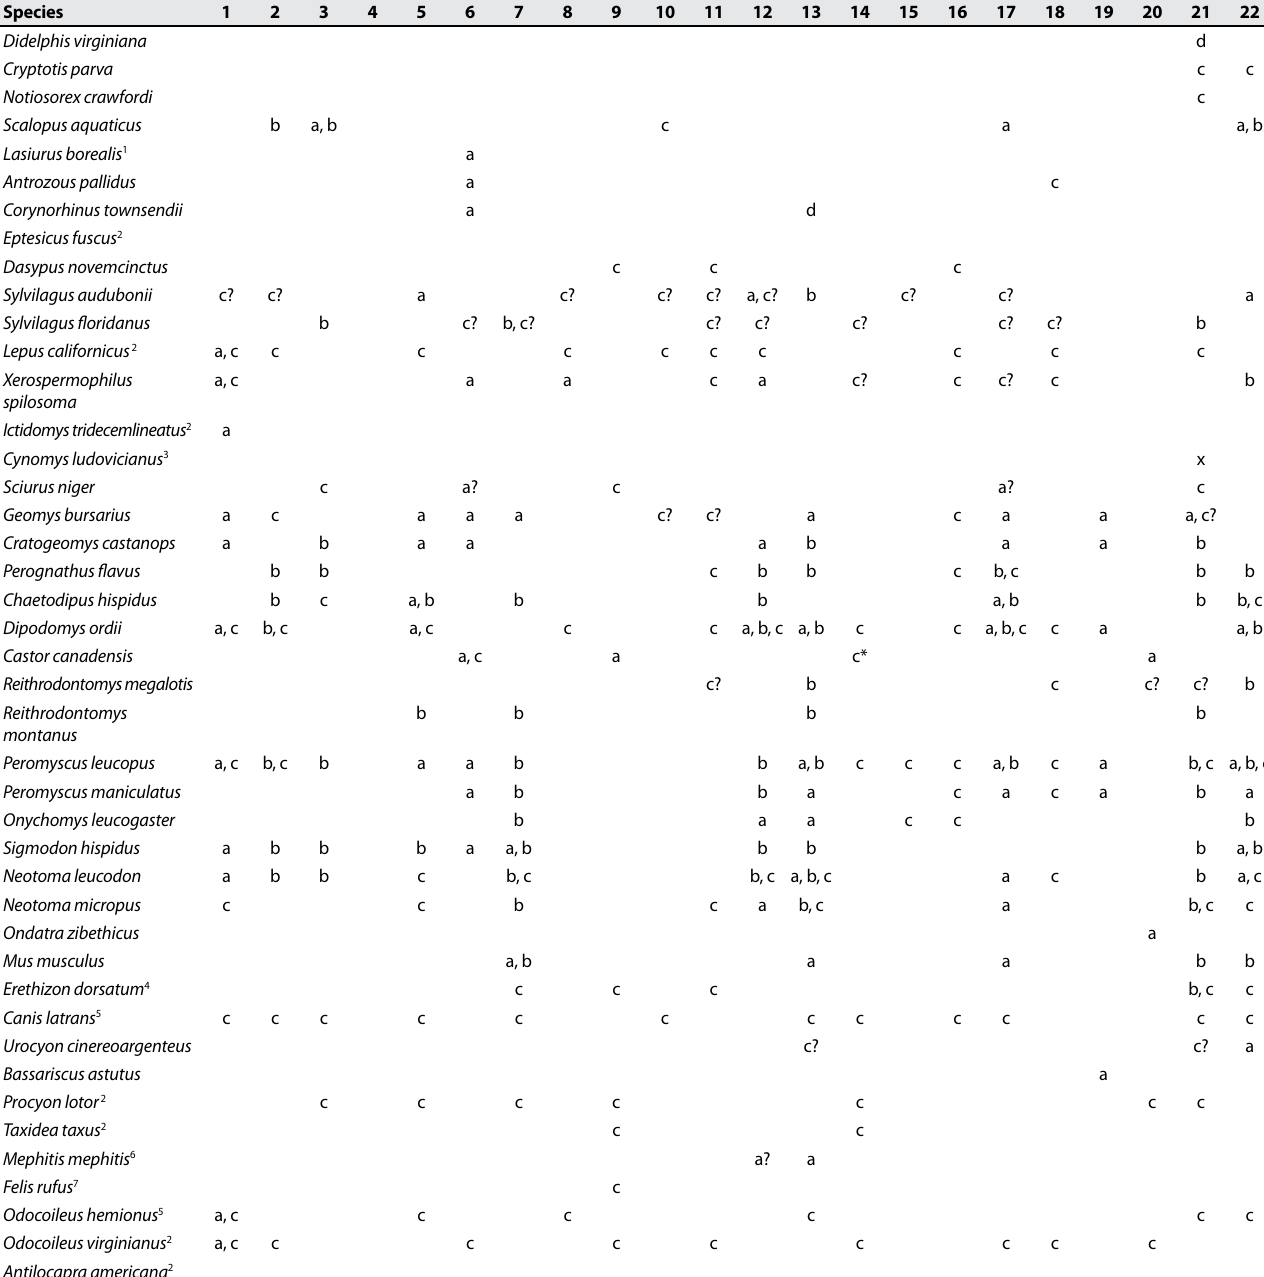
Table 3. Distribution summary by site (see Table 4 for coordinates): from 1978–1979 (a), 1991–1992 (b), and 2001–2003 (c) studies, and opportunistic collection by WTANU faculty and students (d). Legend: (1) Alibates Flint Quarries NM, (2) Bates Canyon, (3) Big Blue Creek, (4) Big Canyon, (5) Blue West, (6) Bonita Creek, (7) Bugbee Canyon, (8) Cas Johnson Road, (9) Chicken Creek, (10) Devil’s Canyon, (11) Dolomite Point grasslands, (12) Fritch Fortress- Cedar Canyon, (13) McBride Canyon, (14) Mullinaw Crossing, (15) North Canyon, (16) North End, (17) Plum Creek, (18) Rosita Meadows, (19) Saddlehorse Canyon, (20) Sanford Marsh, (21) Sanford-Yake, (22) Spring Canyon. (x) small prairie dog town at this location succumbed to plague in 2001, (*) old signs, (?) identification uncertain, e.g., where a species cannot be identified by sight